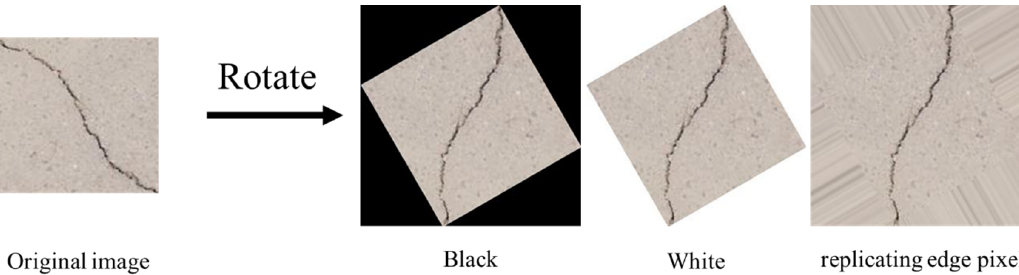
mode. Twenty original images are used, and the data augmentation factor f is Table 2. 𝐹 (cid:3032)(cid:3051)(cid:3047)((cid:2868).(cid:2876)) of the models trained with rotation for data augmentation adopting different padding